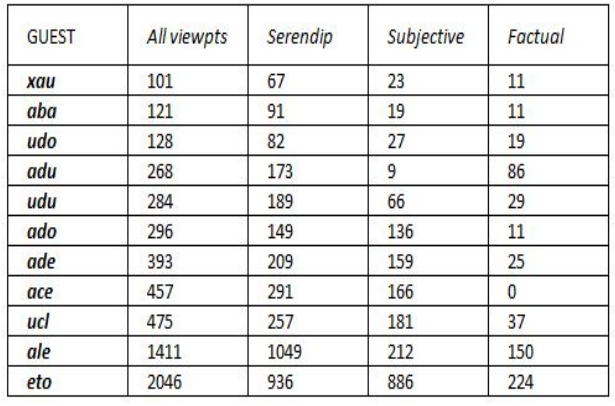
Figure 11. Summary of the dynamics for 11 guests.